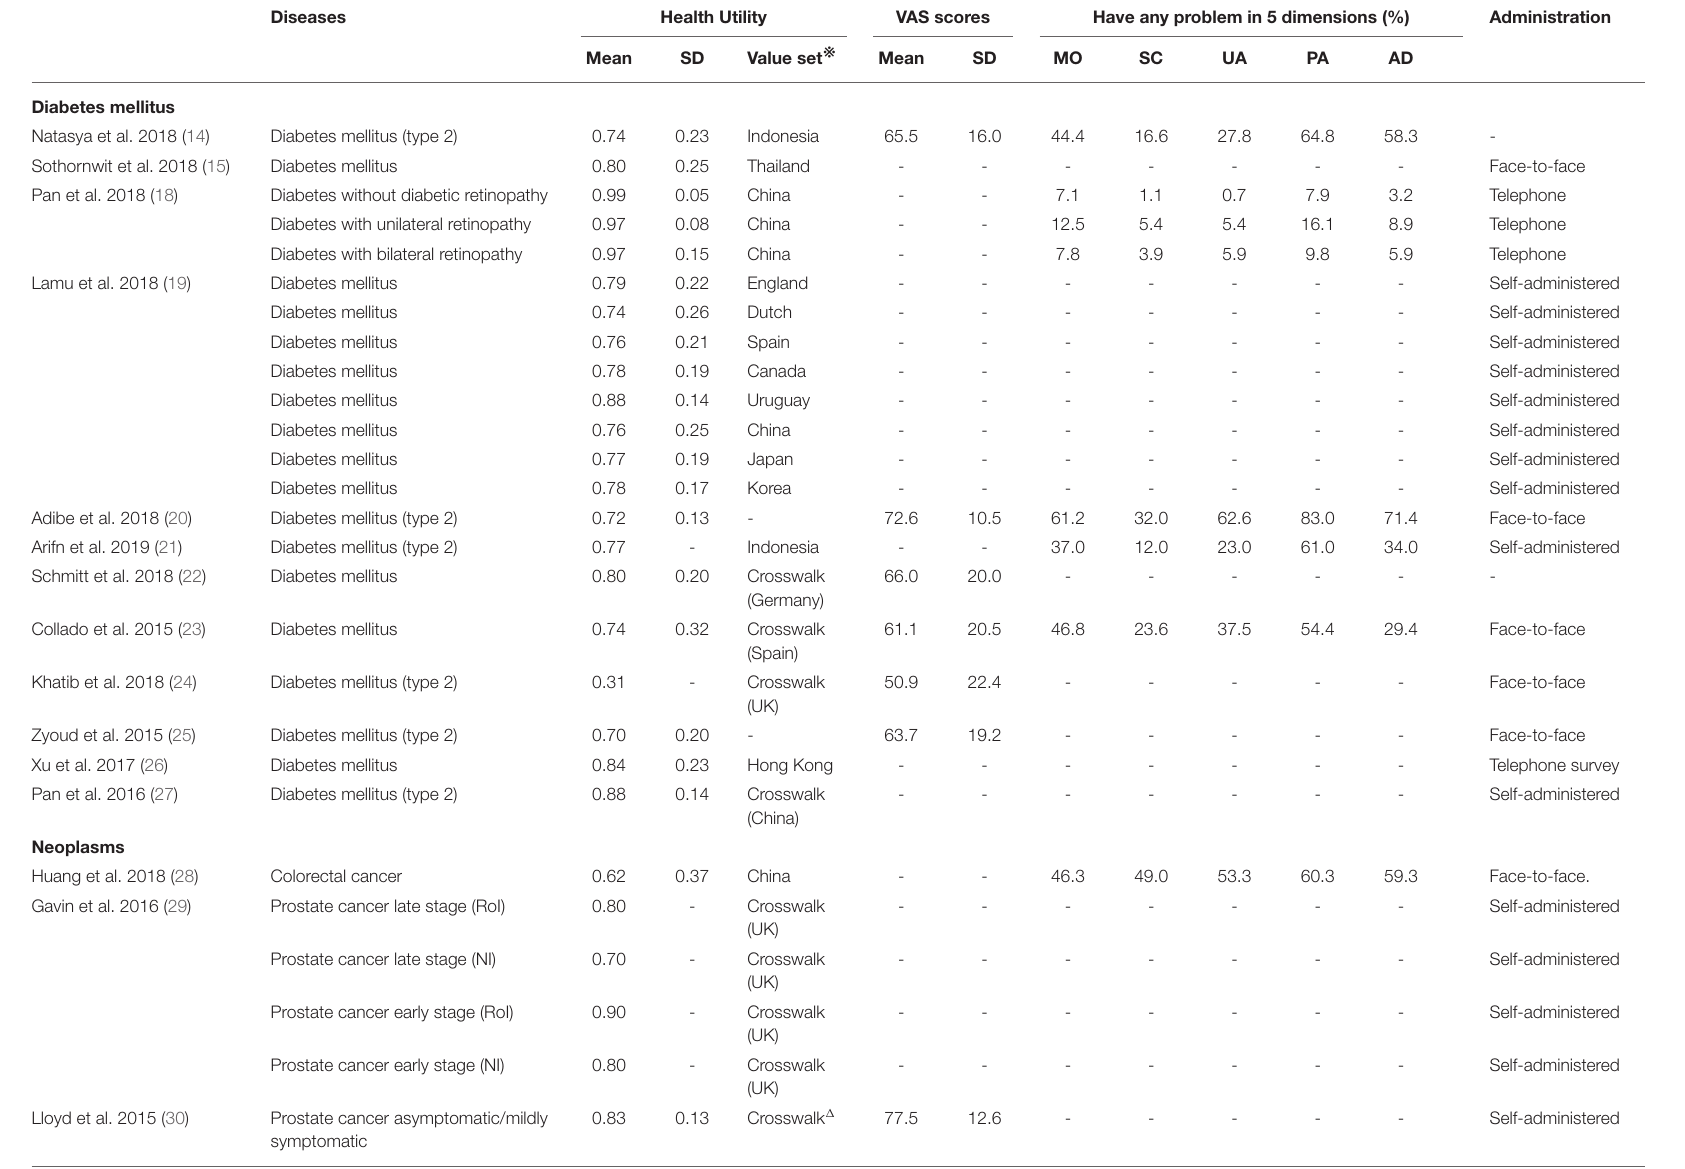
TABLE 2 | HRQoL in patients with different diseases measured by the